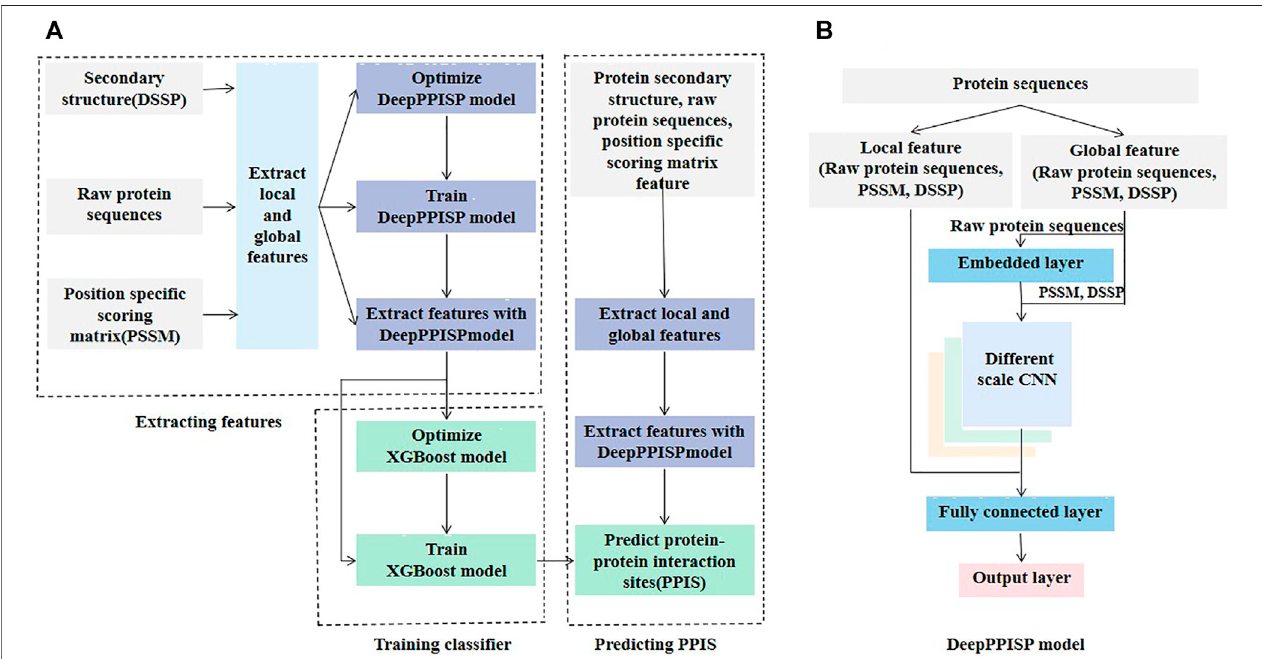
FIGURE 1 | The architecture of DeepPPISP-XGB model. (A) Illustration of the DeepPPISP-XGB work fl ow, which consists of three modules: extracting feature, training classi fi er, predicting PPIS. (B) The architecture of DeepPPISP model, which contain embedding layer, different scale convolutions, fully connected layers and output